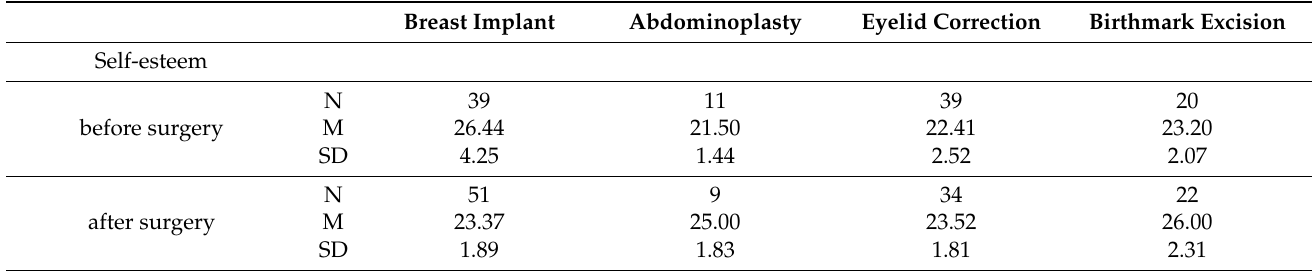
Figure 10. Comparison of the subjective self-esteem with regard to the patient’s body before and after the procedure.